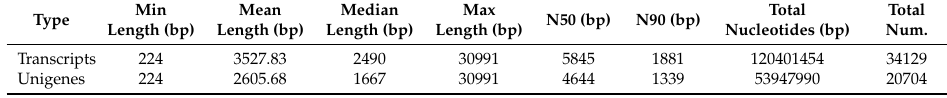
Table 2. Properties of assembled transcripts and unigenes.